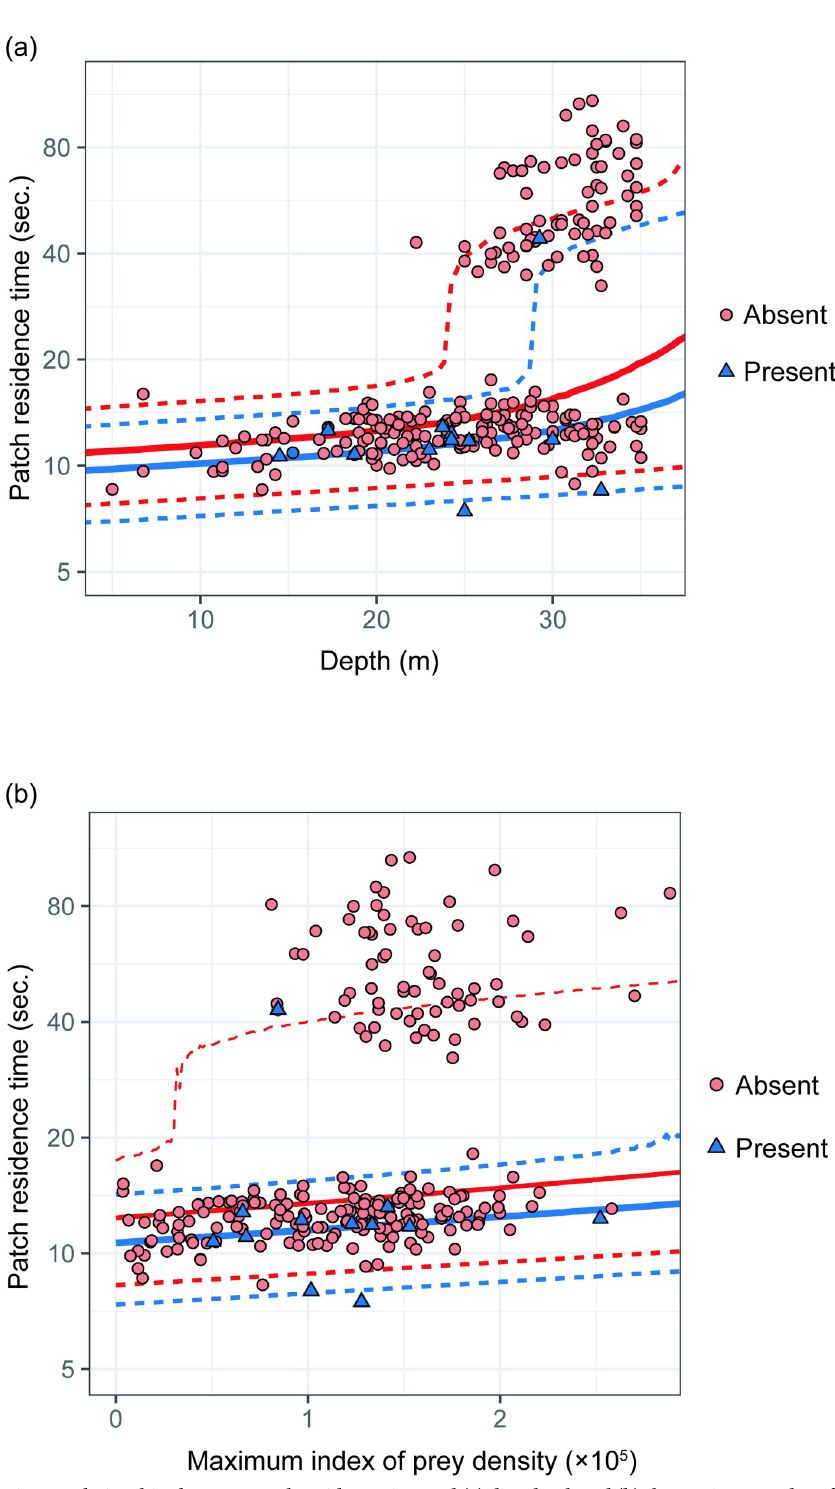
Fig 8. Relationships between patch residence time and (a) dive depth and (b) the maximum Index of Prey Density (IPD) for four whales. The red points represent absent (n = 232) dives and blue triangles represent present dives (n = 12). The points show the patch residence time, rescaled so that the effect of MIPD is normalized to its mean value in (a), and the effect of depth is normalized to its mean value in (b). The solid lines represent the mean values and the dashed lines represent the 95% prediction intervals of posterior distribution computed from the